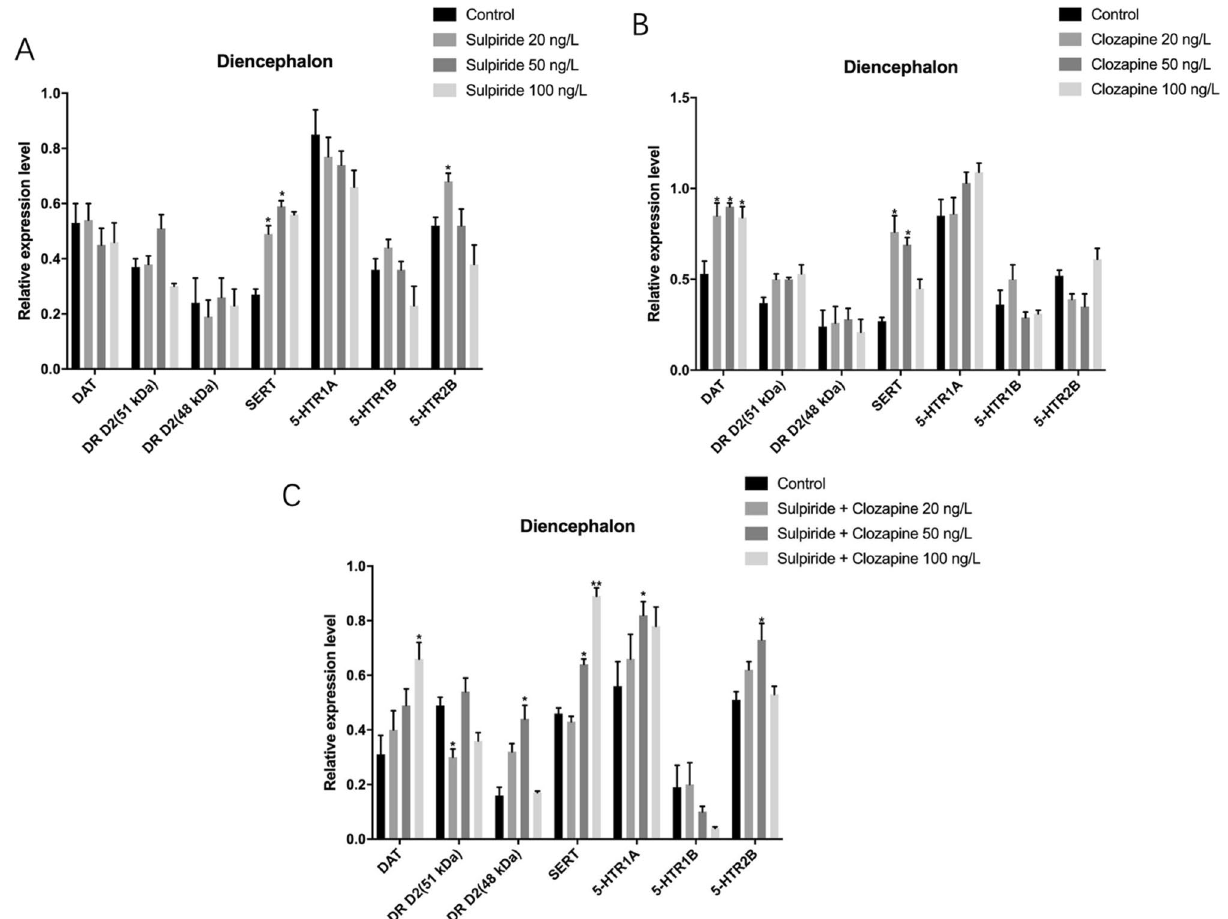
Figure 5. Changes in the protein levels of functional molecules involved in DAergic and 5-HTergic systems in zebrafish diencephalon induced by sulpiride and clozapine. Note: ( A ) Sulpiride, ( B ) Clozapine, ( C ) Mixture of sulpiride and clozapine. Data are presented as means ± SE (n = 20). p < 0.05 was considered statistically significant. * p < 0.05, ** p <